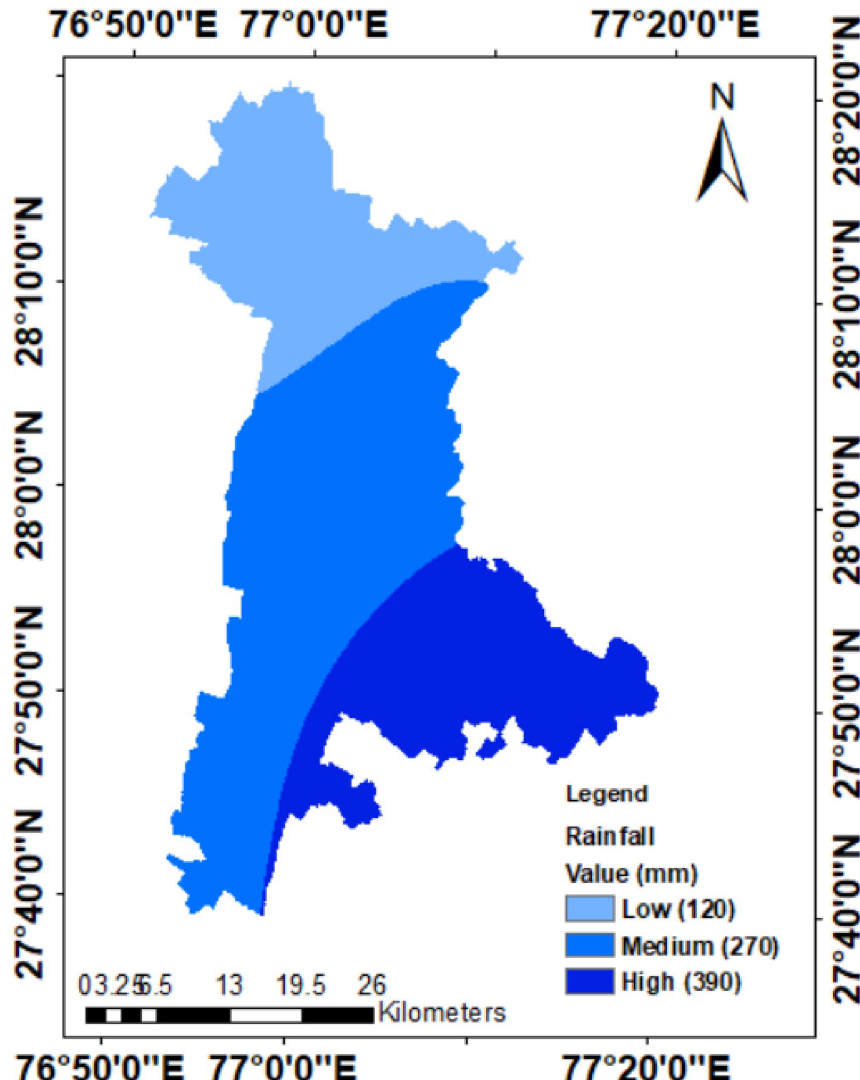
Fig. 14 Rainfall map (2011– 2020) of study